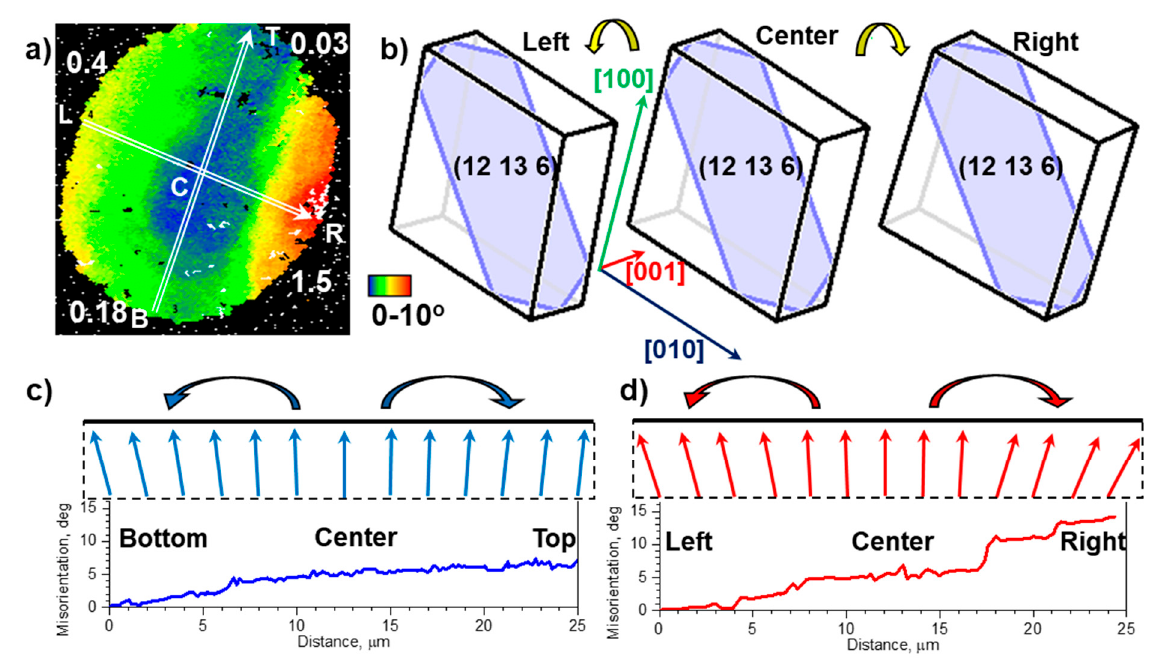
Figure 7. The orientational changes for single crystal dot #2 fabricated via the “ring” procedure. ( a ) Crystal orientation deviation (COD) map with reference to the crystal orientation at the center of the dot. Numbers in ( a ) indicate the average rotation rate (in degrees/ µ m) between the center of the dot ( C ) and corresponding periphery point indicated by the white lines for the top ( T ), bottom ( B ), left ( L ), and right ( R ) points of the crystal. ( b ) The crystal lattice orientation as it rotates as described by the yellow arrows. The plots ( c , d ) shows the misorientation profile that describes the misorientation of the lattice orientation between neighboring points from bottom to top ( c ) and left to right ( d ).